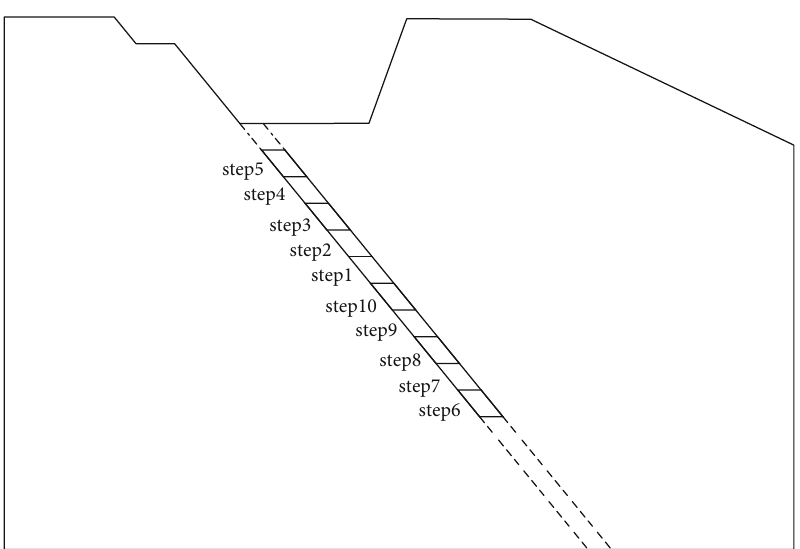
Figure 3: Mining method and